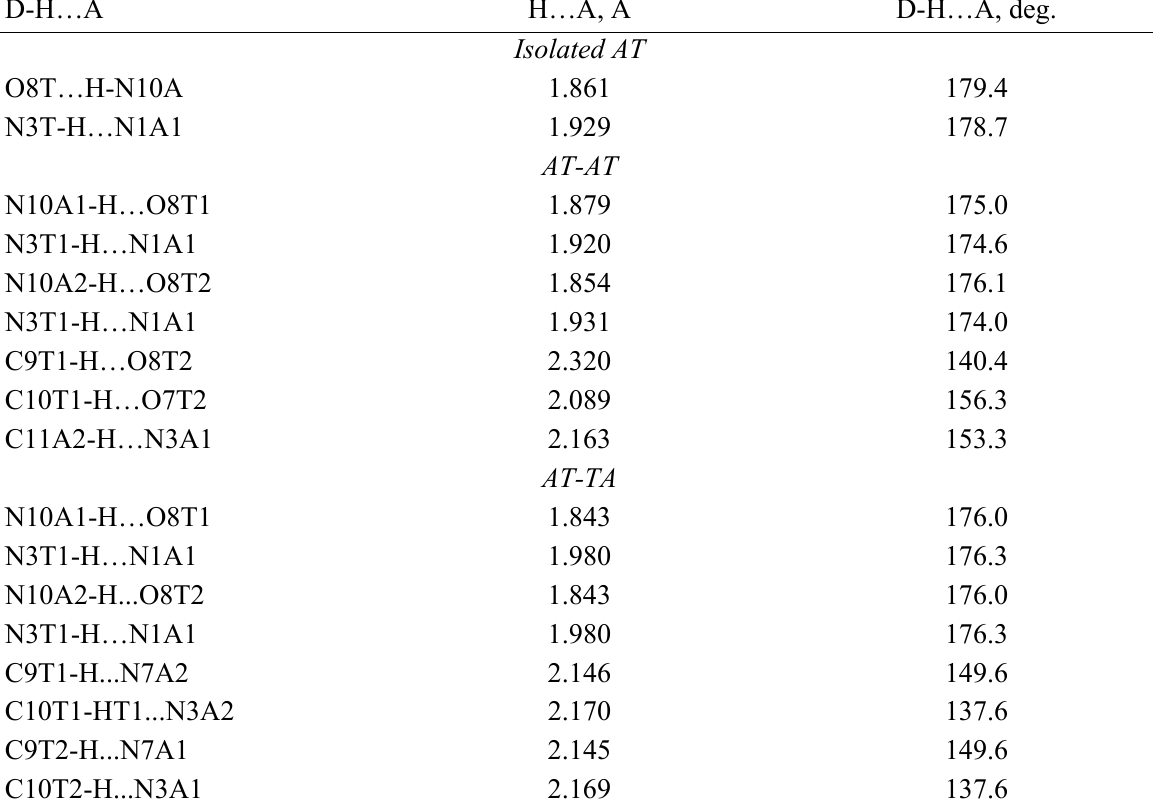
Table 2. Geometrical parameters of the hydrogen bonds in stacked dimers and in isolated AT base pair.